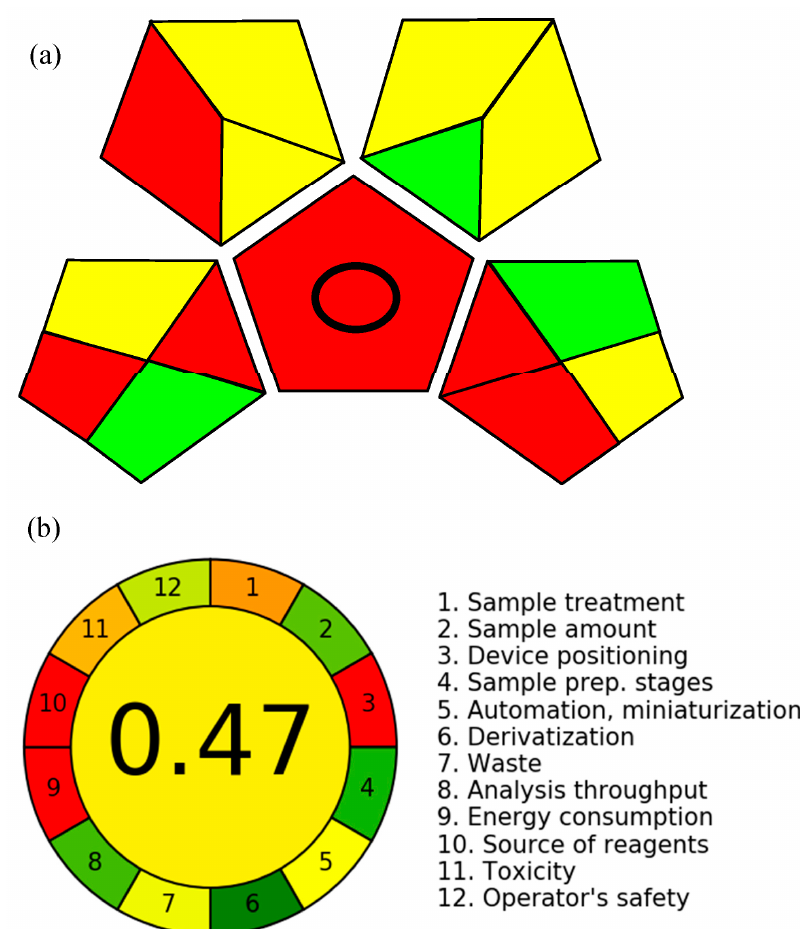
Figure 7. Greenness evaluation of developed method using (a) GAPI and (b) AGREE metrics.